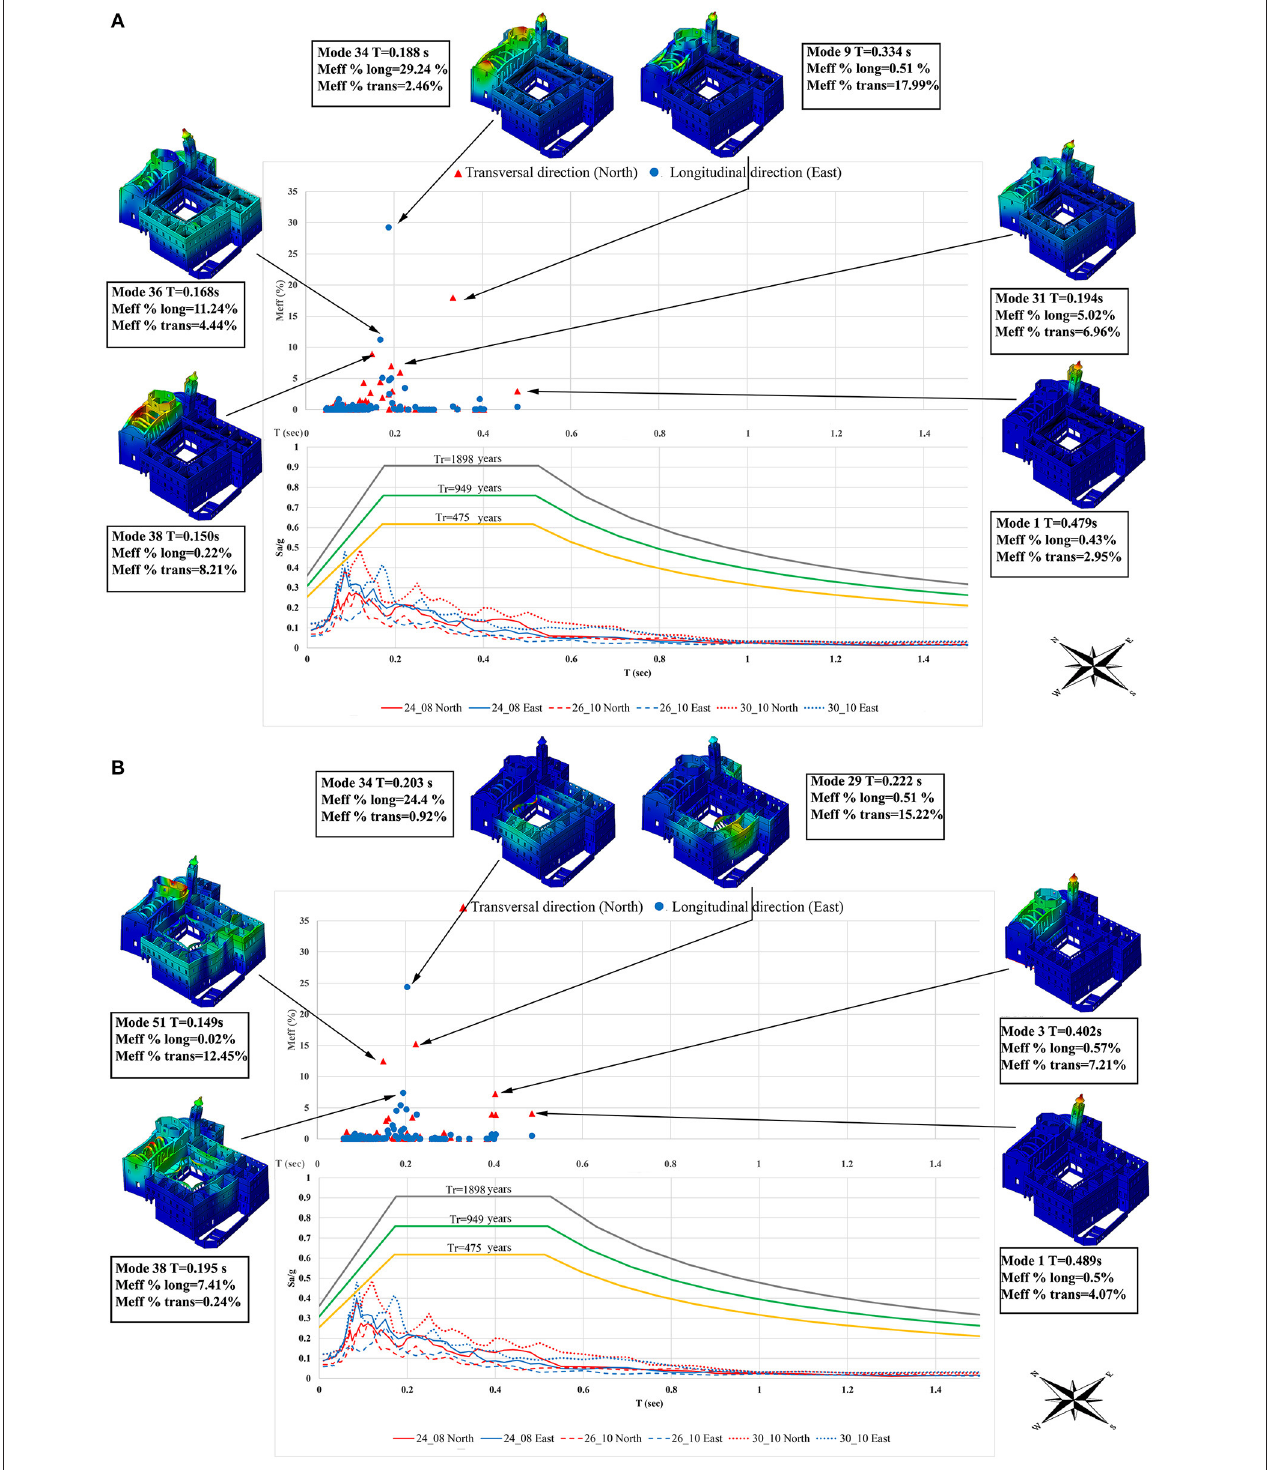
FIGURE 5 | Distribution of modal shapes in the longitudinal and transversal directions and comparison with the pseudo-acceleration response spectra (three main shocks of Central Italy 2016–2017 seismic sequence), and the Italian code elastic response spectrum for the Model CS (A) , Model DF (B) .